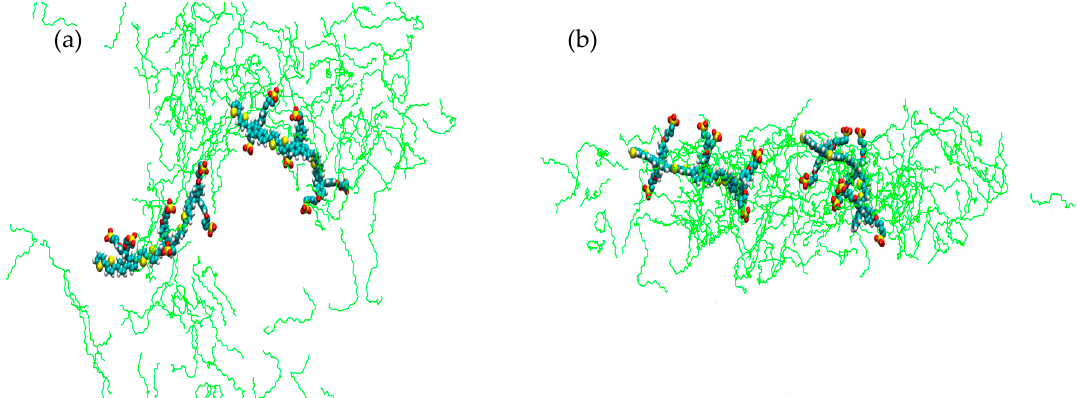
Figure 4. Simulation cell representation of ( a ) front view; and ( b ) side view of 680 mM C 12 E 5 with two equivalents of PBS-PF2T at 20 °C after 10 ns, system 3 . (PBS-PF2T is shown in van der Waals representations and solvent is omitted for clarity).